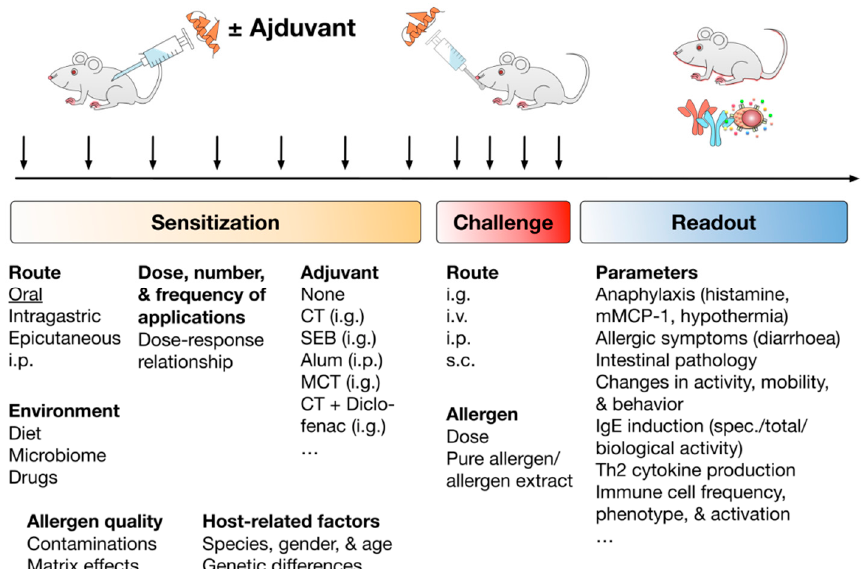
Figure 3. Experimental setup, factors contributing to the successful establishment, and readout parameters typically investigated in the published mouse food allergy models. Successful establishment of allergic sensitization in mouse food allergy models was shown to depend on the route of allergen application, dose, frequency, and number of applications, as well as the used adjuvant. In addition, environmental factors such as diet, microbiome of the used animals, and the eventual usage of drugs during the sensitization, allergen quality with respect to contaminations with either other proteins or endotoxins, matrix effects of the applied allergen extract, and host-related factors such as used mouse strain, gender, and age of the used animals, but also genetic differences were shown to be critical factors in allergic sensitization. Subsequently to successful allergic sensitization animals are challenged with either purified allergens or allergen-containing allergen extracts to elicit the allergic reaction. The main differences in the published mouse food allergy models are observed for the routes of allergen application, allergen dose, and usage of either purified allergic reactions are evaluated according to certain readout parameters. These readout